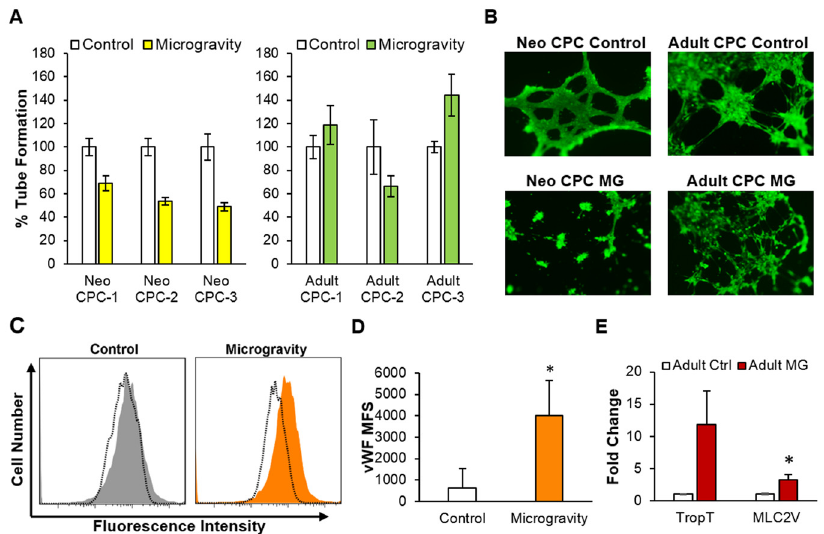
Fig 5. Cardiac progenitor cell differentiation after 6 – 7 days of simulated microgravity. A) Quantification of tube formation using Image pro plus software. Reduced tube formation was present in neonatal CPCs after simulated microgravity whereas 2 of 3 adult CPCs exhibited elevated tube formation after simulated microgravity. B) Representative images of tube formation in neonatal and adult CPC after 6 – 7 days of simulated microgravity. C) Representative flow cytometry histogram of increased von Willebrand Factor (vWF) expression in adult CPCs after simulated microgravity. Positive staining is represented by a colored histogram, secondary alone staining is represented as a dotted line. D) Quantification of von Willebrand factor protein expression in adult CPCs (n = 3, p = 0.047). Mean fluorescence shift above secondary antibody alone is shown above. E) Relative expression of genes associated with cardiac differentiation in adult CPCs after 6 – 7 days of simulated microgravity by RT-PCR. Myosin light chain 2 (MLC2V) an early indicator of cardiovascular differentiation was significantly elevated in adult CPCs (n = 3, run in triplicate P =